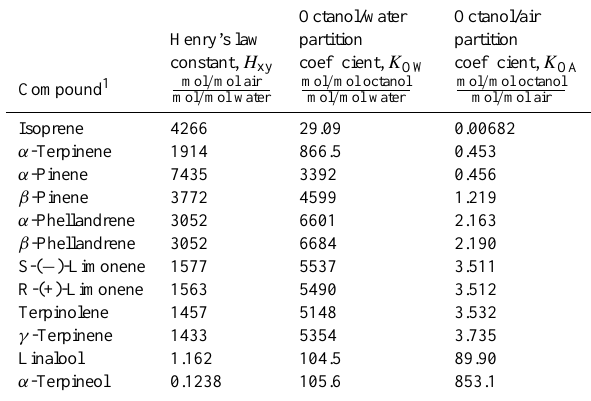
Table 1. Variation in physico-chemical characteristics of iso- prene, non-oxygenated monoterpenes and monoterpene alcohols α - terpineol and linalool at 25 ◦